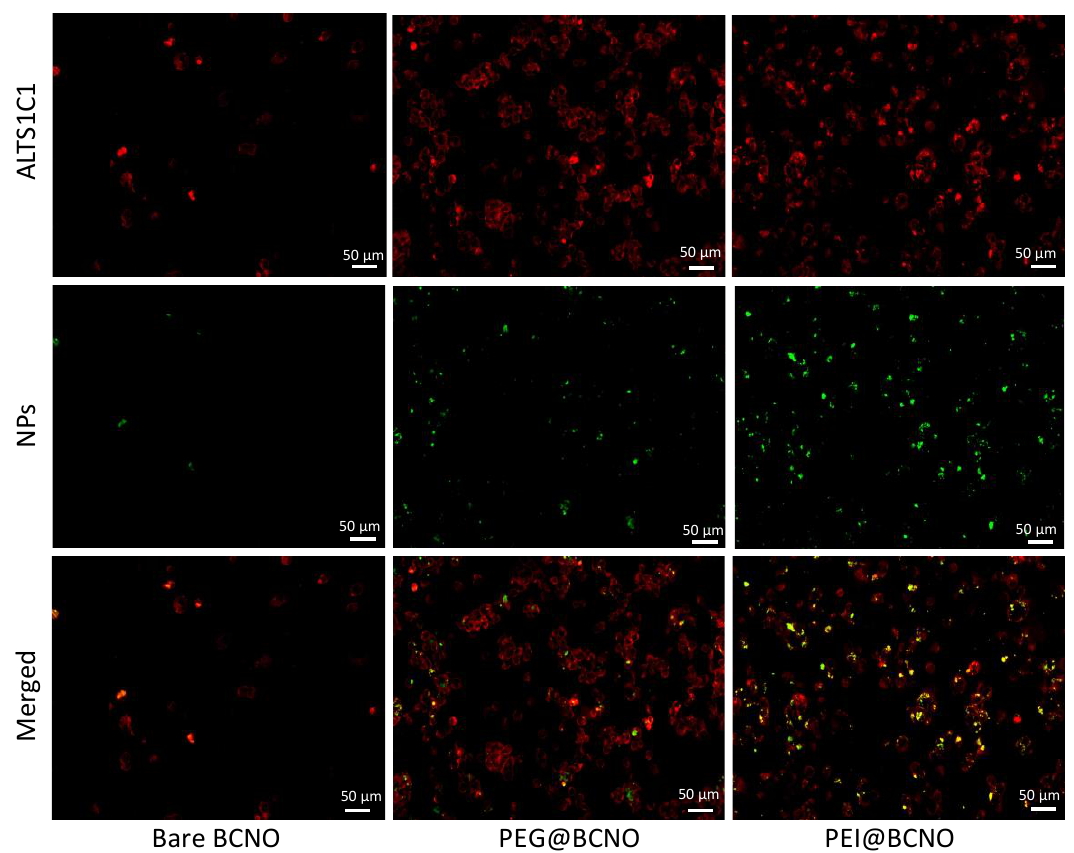
Figure 8. Fluorescence microscopy images of bare BCNO, PEG@BCNO and PEI@BCNO incubated with ALTS1C1 cells for 4 h. The red fluorescence corresponds to the ALTS1C1 cells stained with Fast-dil, while the green fluorescent correspond to the BCNO nanoparticles. Scale bar: 50 µm.